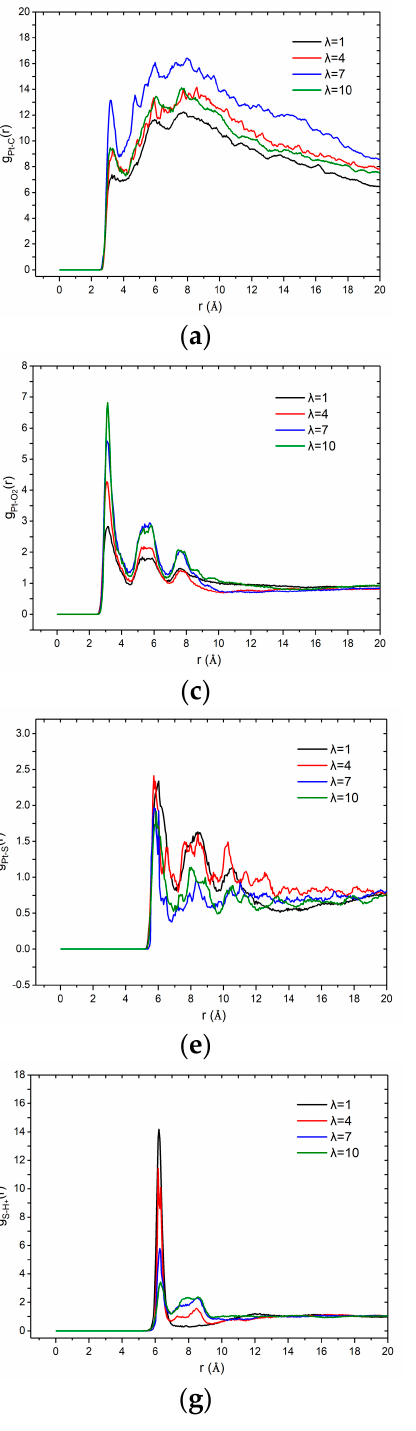
Figure 5. Radial distribution functions (RDF) values of the multi-components as a function of water content: ( a ) Pt–C; ( b ) Pt–H + ; ( c ) Pt–O 2 ; ( d ) S–S; ( e ) Pt–S; ( f ) S–H 2 O; ( g ) S–H + ; and ( h ) O 2 –O 2 .